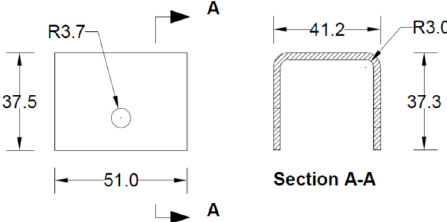
Figure 11. Details of main lock channel (all dimensions are in mm, steel plate gauge 11).